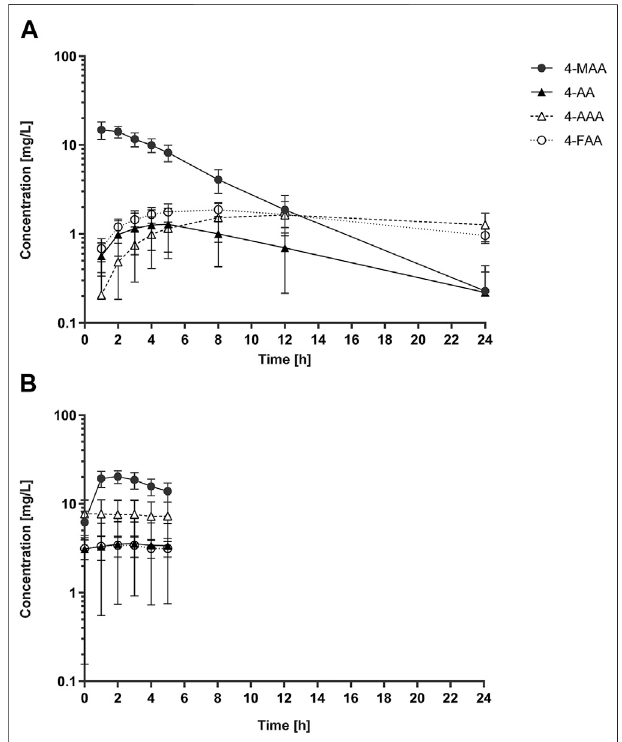
FIGURE5| Pharmacokineticpro fi lesofmetamizolemetabolites.Plasma concentration vs time pro fi les of the four metamizole metabolites 4-MAA, 4- AA, 4-FAA and 4-AAA in healthy volunteers ( n (cid:1) 8) following a single oral dose of 1,000 mg metamizole (A) and after 7 days of continuous intake of 1,000 mg metamizole three times per day (B) . In panel (B) only data from the fi rst dose interval (0 – 5 h) is shown. Data are presented as mean and